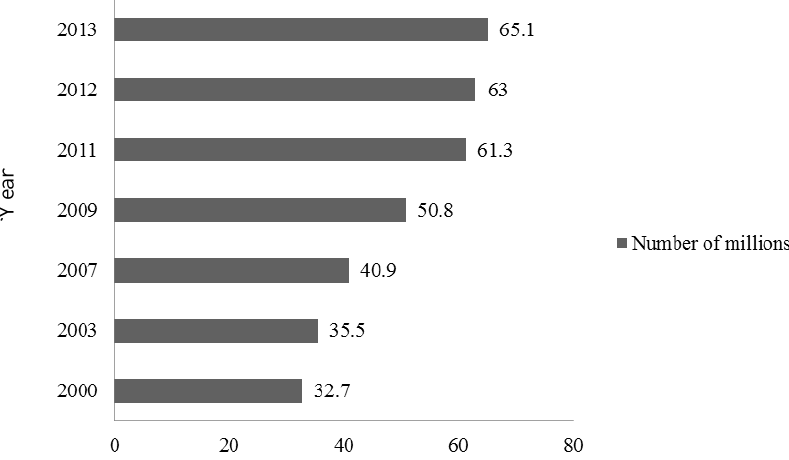
Figure 2. Number of patients with diabetes in India,